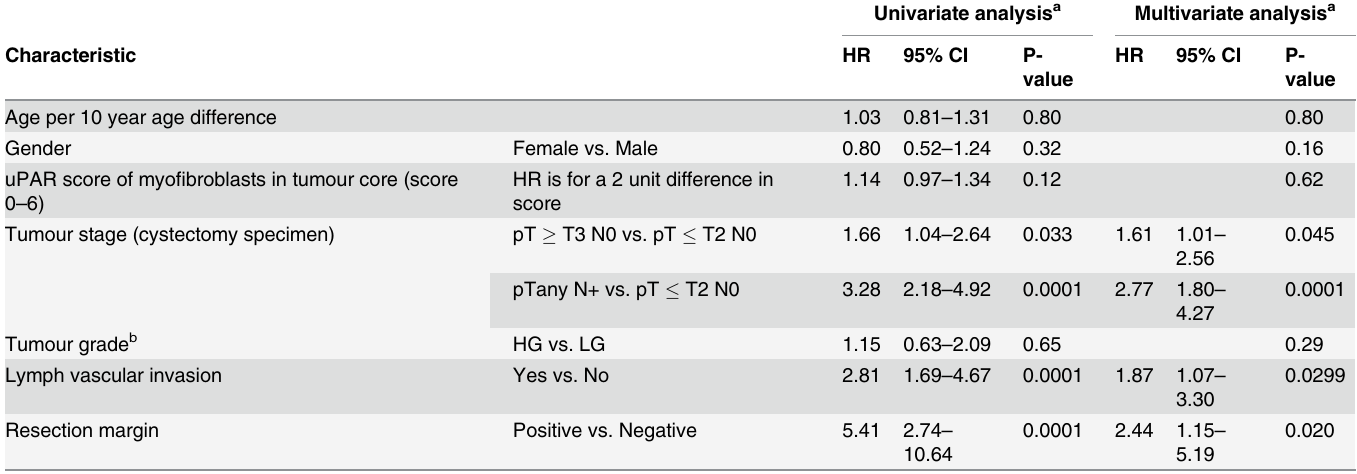
Table 4. OS. Univariate and multivariate